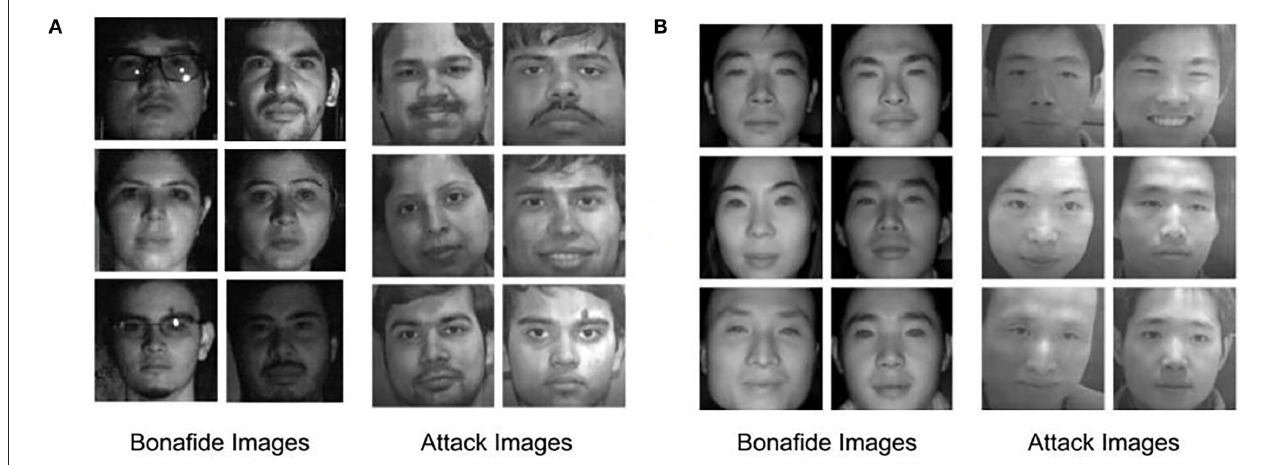
FIGURE 1 | Sample face images from the proposed Spoof-in-NIR database. Images are shown from (A) Indian ethnicity and (B) Chinese